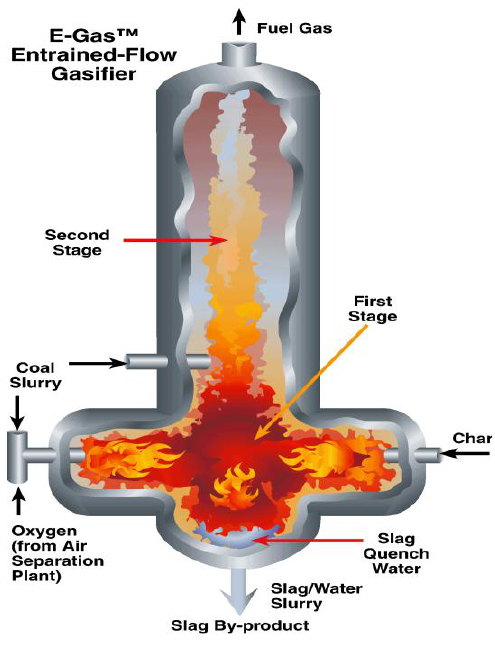
Figure 7. Conoco Philips E-Gas [1].